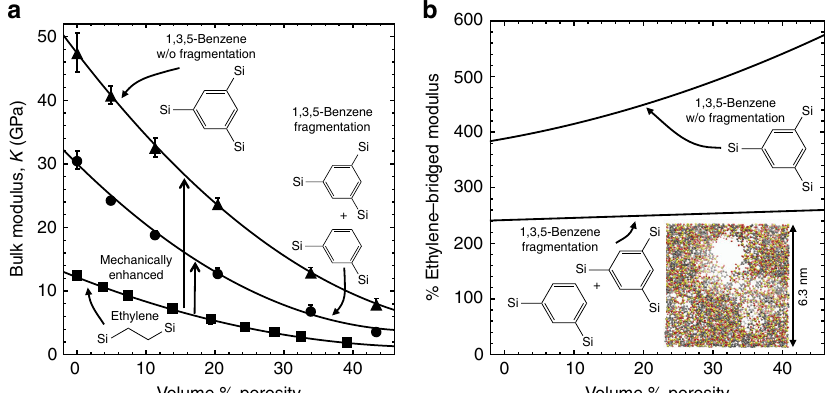
Fig. 4 Hyperconnected network architectures enhance the modulus of highly nanoporous glasses. a The bulk moduli of pure ethylene-bridged, pure 1,3,5-benzene-bridged, and fragmented 1,3,5-benzene-bridged model glasses are plotted against the volume% porosity. The error bars denote one standard deviation of the mean of three trials per condition. b The moduli of the pure 1,3,5-benzene (top) and fragmented 1,3,5-benzene (bottom) glasses are shown as the percentage of the ethylene-bridged modulus as a function of volume% porosity. The inset is a visualization 67 of a 1,3,5-benzene-bridged nanoporous